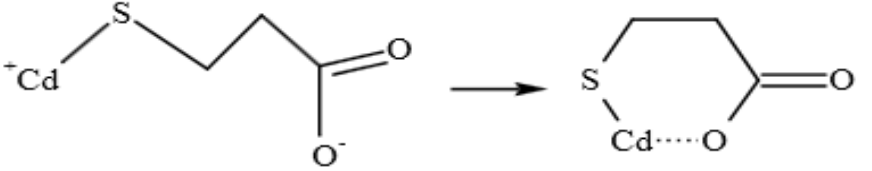
Figure 5. The structure of the complex formed by thioglycolic acid and Cd 2+ .